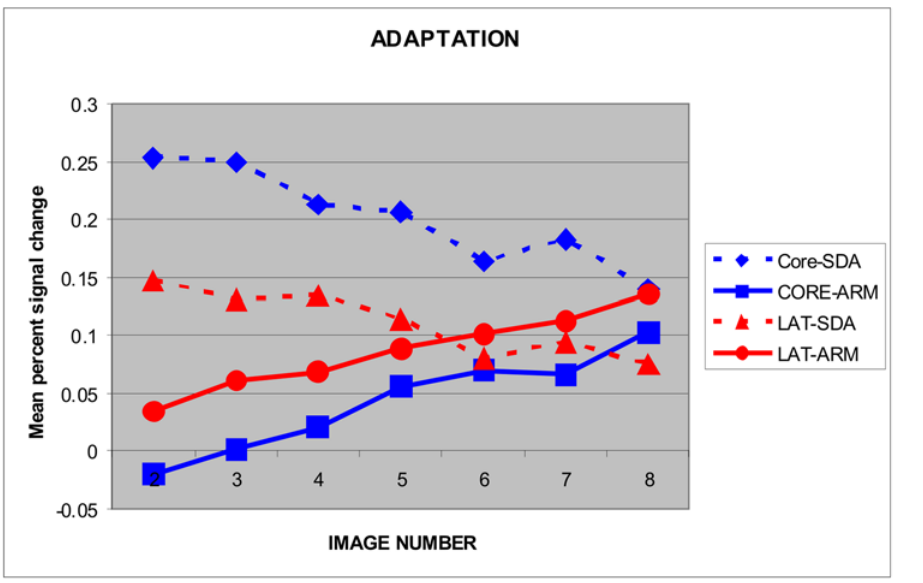
Figure 13. Adaptation of SDAs and ARMs. Mean percent signal change for SDAs and ARMs in medial and lateral grids across successive images 2–8 of each block during continuous sampling.